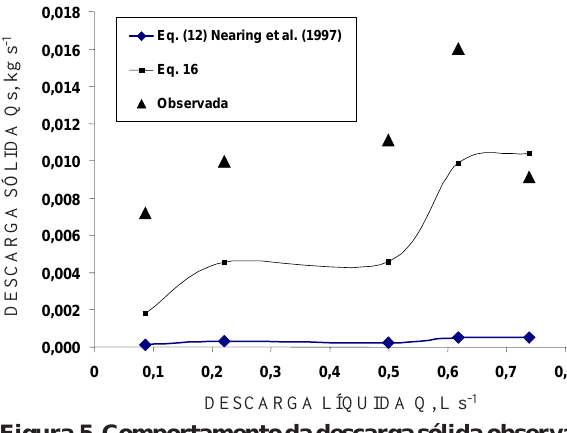
Figura 5. Comportamento da descarga sólida